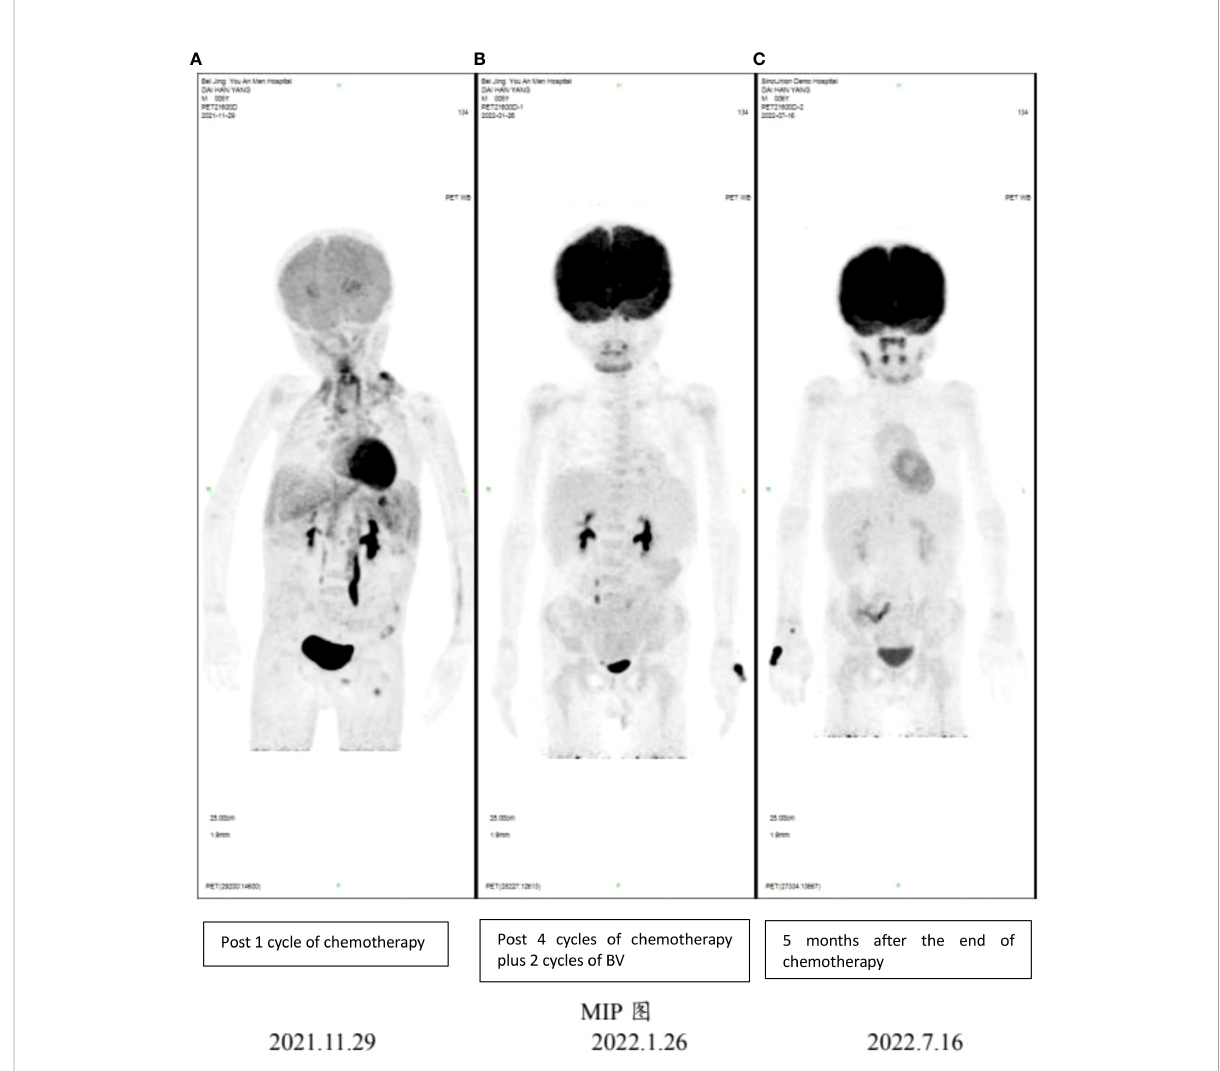
FIGURE 2 PET-CT imaging showing early response following 4 cycles of chemotherapy plus 2 cycles of BV and sustained remission in this patient. (A) PET-CT results for the patient on 11/29/2021; (B) PET-CT results for the patient on 01/26/2022; (C) PET-CT results for the patient on